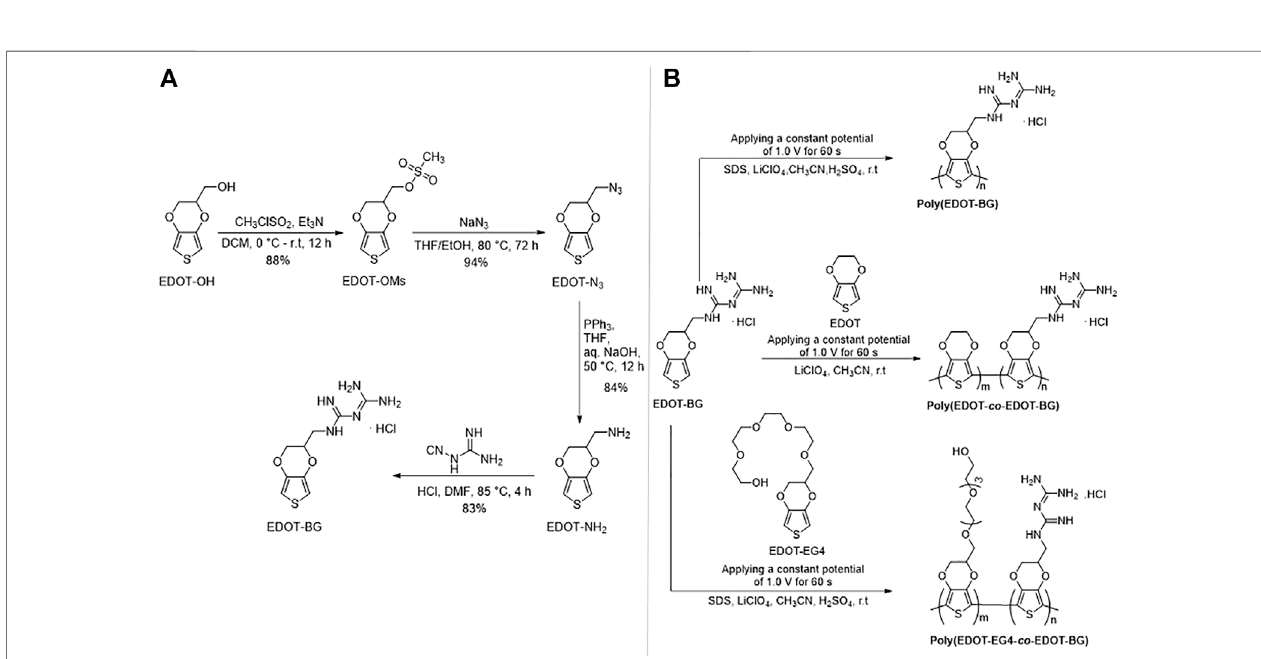
FIGURE1|(A) Three-electrodesystemelectropolymerizationcellset-up[thepurplecoloroftheworkingelectrode(ITO-glass)showstheelectrodepositedpolymer fi lm] and (B) photo of the polymer fi lms of poly(EDOT-BG) (i), poly(EDOT-BG- co -EDOT-EG4) (ii), PEDOT (iii), and poly(EDOT- co -EDOT-BG) (iv) electrodeposited on ITO-glass